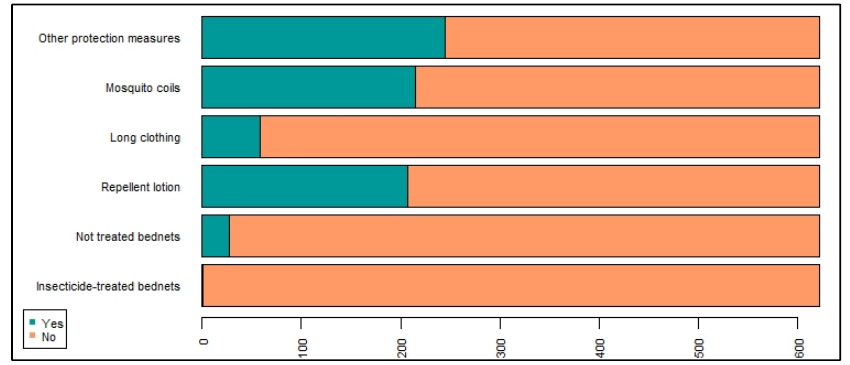
Figure 5. Repartition of the different protective measures reported by study participants.